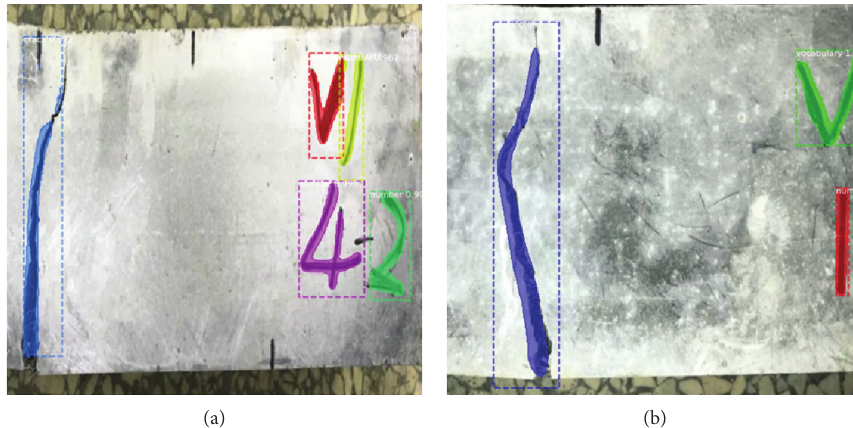
Figure 9: The test results of improved Mask R-CNN crack detection model. Table 4: Detection results of improved Mask R-CNN.